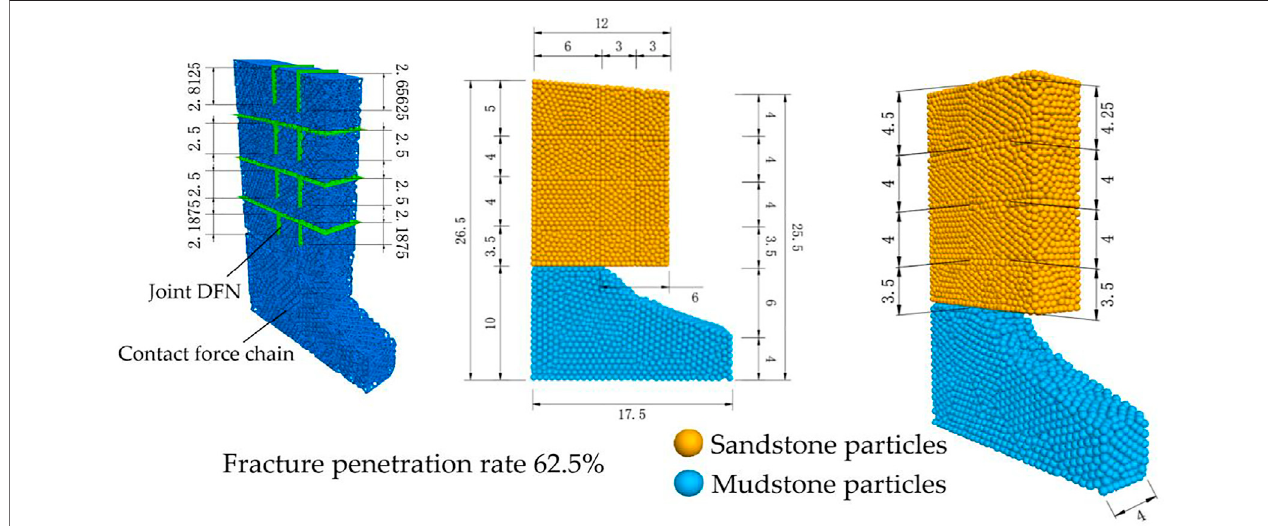
FIGURE 7 | 3D particle fl ow